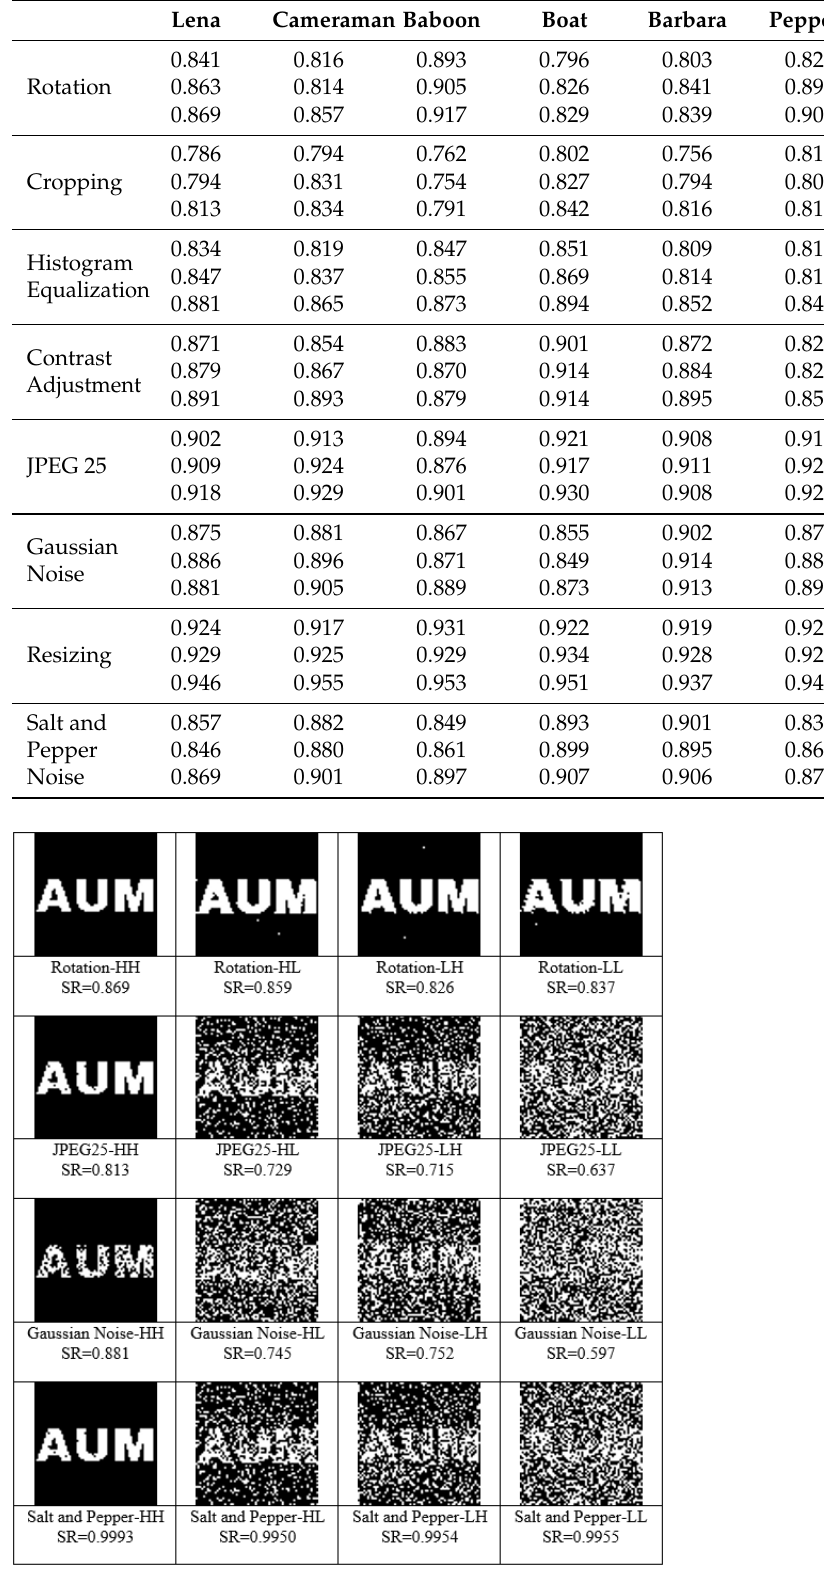
Figure 5. Similarity ratio values for extracted watermark from Lena image using FSF block water-